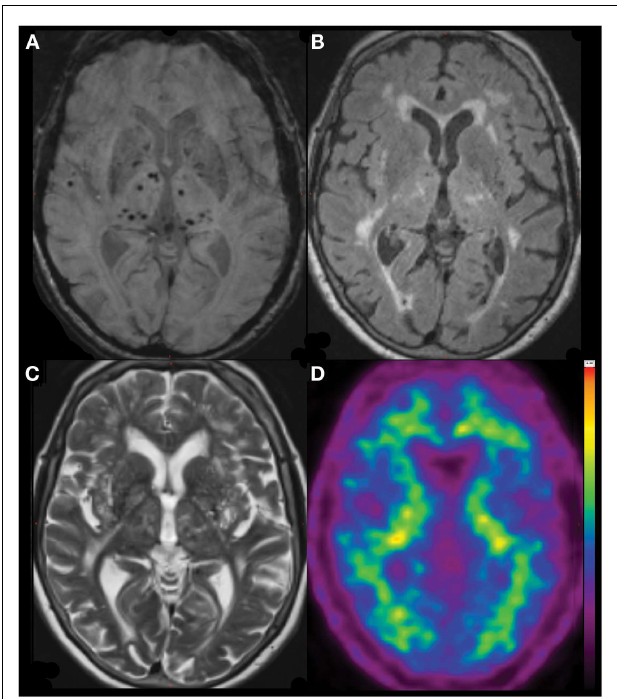
FIGURE 1 | Diffuse (predominantly non-lobar) Microbleeds in an 81-year-old lady referred withAD-type dementia (MMSE 22/30, CDR 1, CDR-SOB 5.5) . SWI image (A) , with coregistered FLAIR (B) ,T2 (C) and 11C-PiB PET (D) images demonstrating severe deep white matter hyperintensities but no significant beta-amyloid burden (neocortical SUVR = 1.2), suggesting that the presentation is due to severe cerebral